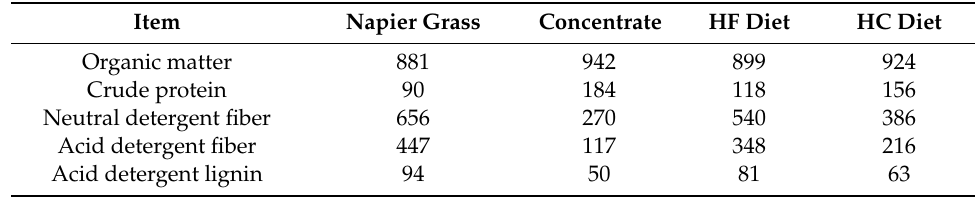
Table 1. Nutrient composition of dried Napier grass, concentrate, and high-forage (HF) and high-concentrate (HC) diets (in mg / g dry matter (DM)). Item Napier Grass Concentrate HF Diet HC Diet Organic matter 881 942 899 924 Crude protein 90 184 118 156 Neutral detergent fiber 656 270 540 386 447 117 348